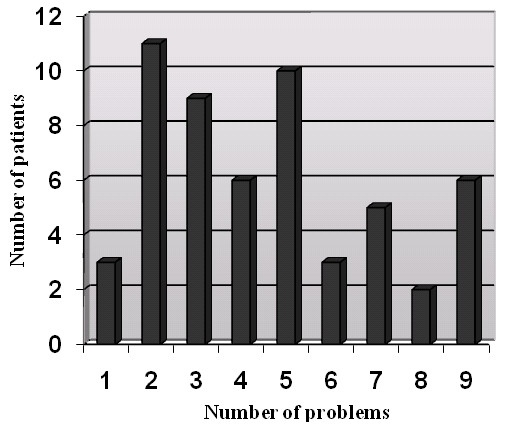
Summary of frequencies of problems detected by the multidimensional assessment from Table 4.